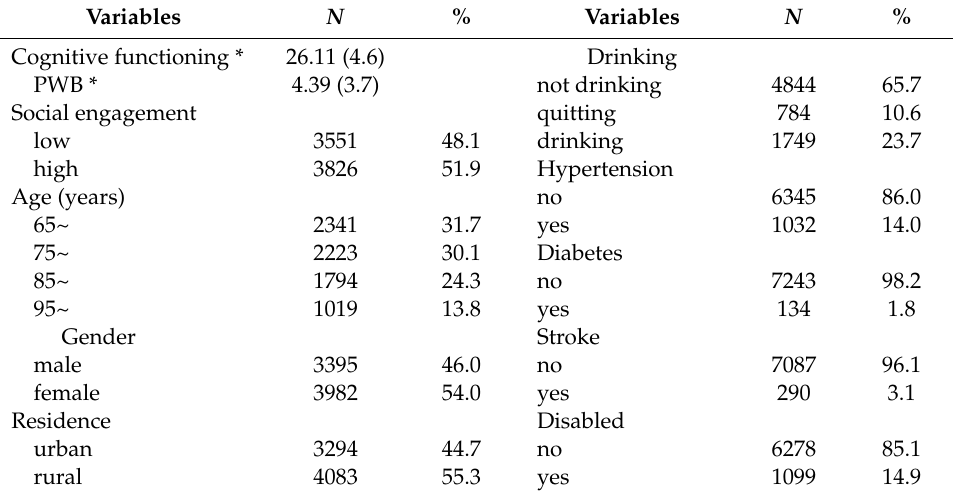
Table 1. The distribution of covariates at baseline (n /